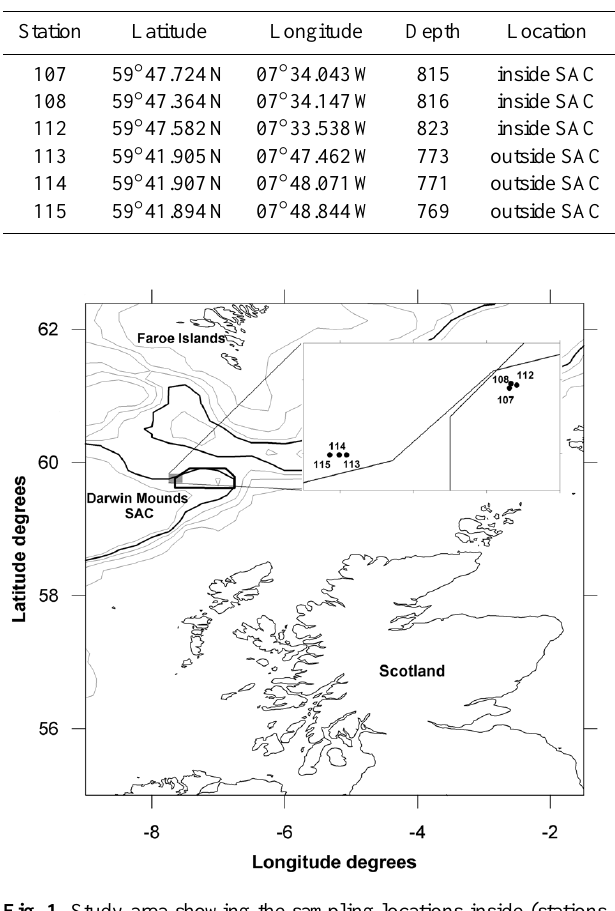
Fig. 1. Study area showing the sampling locations inside (stations 107–108 and 112) and outside (stations 113–114 and 115) the SAC. The SAC area and the 800m contour are shown in